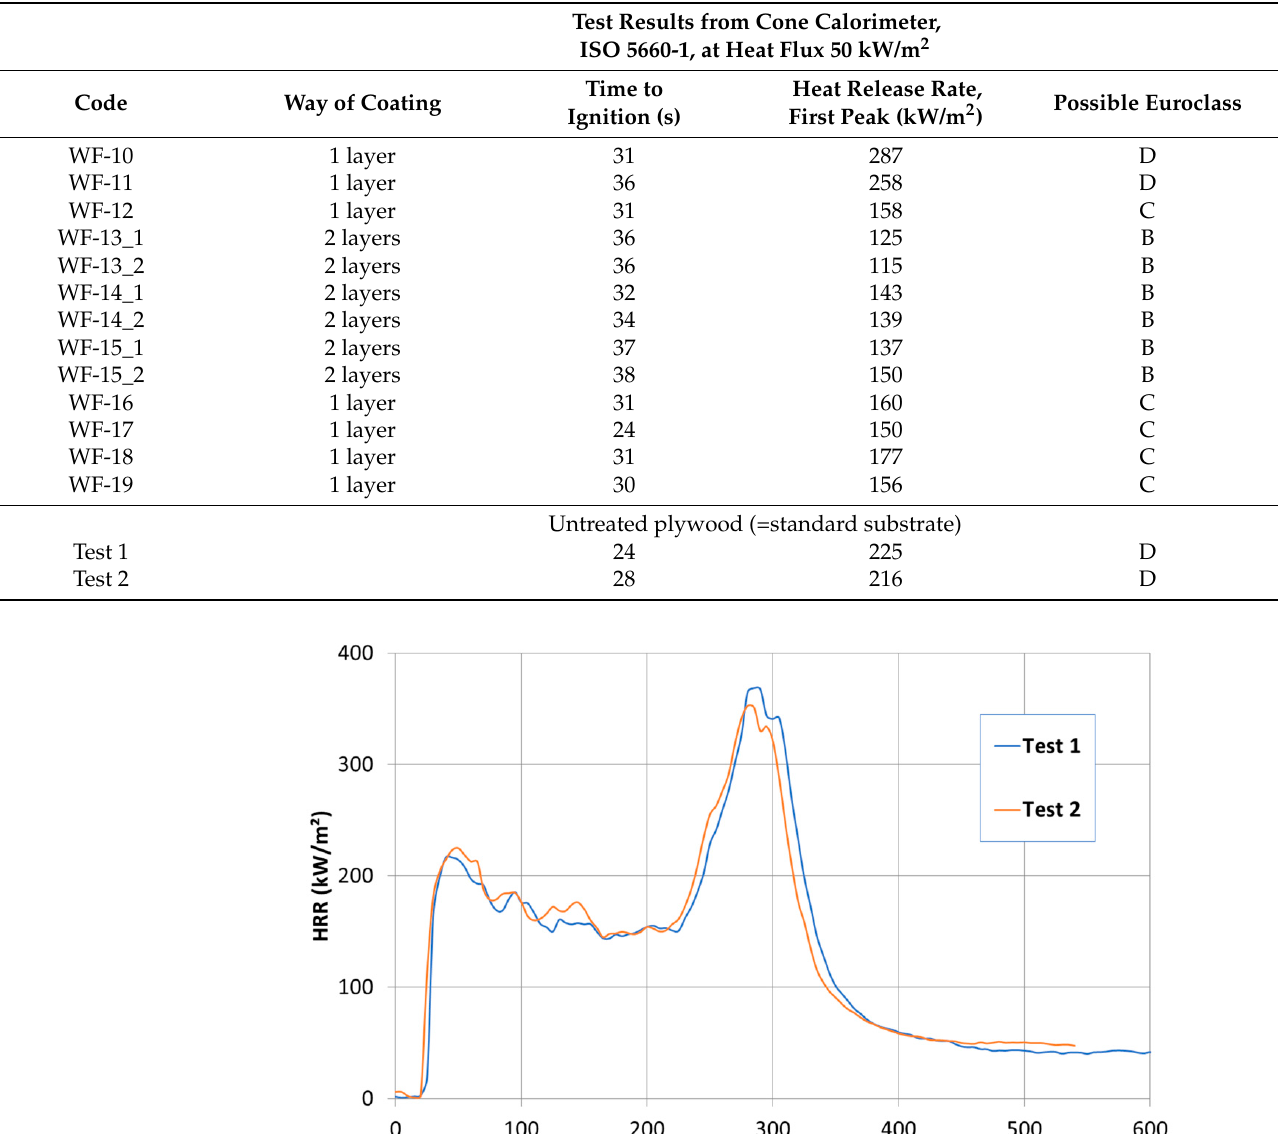
Table 3. Reaction-to-fire test results for coatings and predicted possible European fire classes.